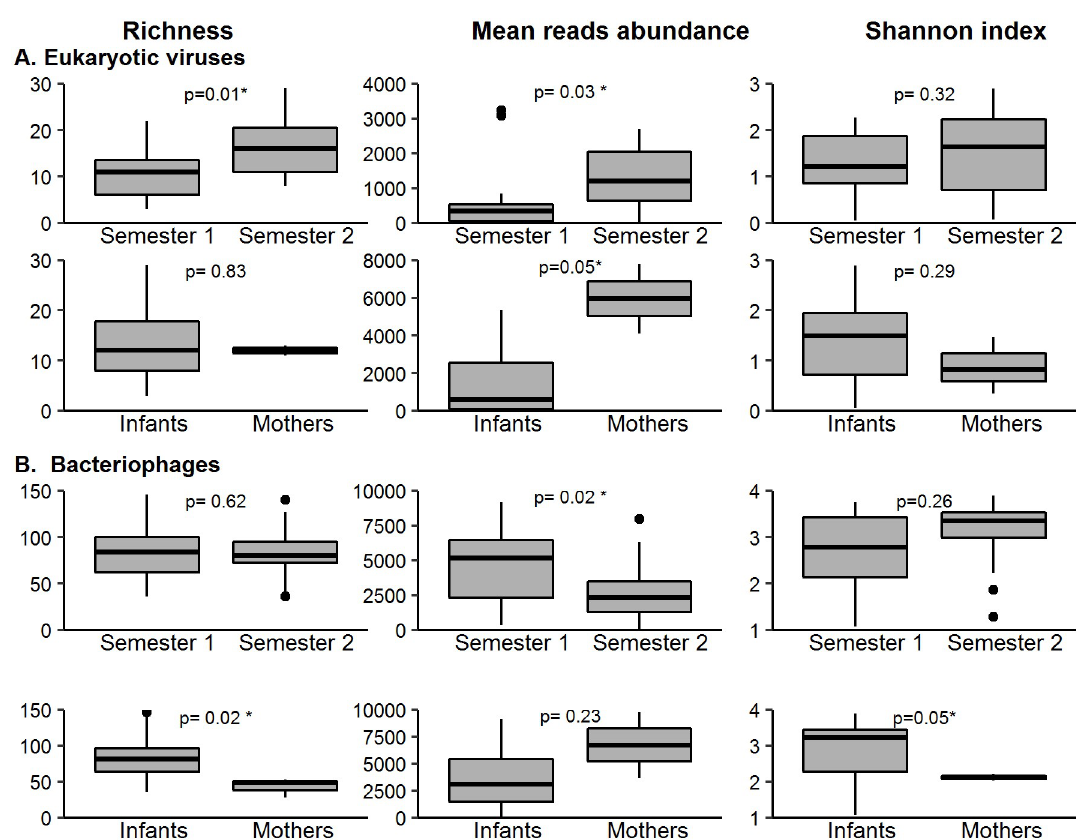
Fig 5. Bar plots representing viral diversity metrics as Chao richness index, mean abundance per species and Shannon diversity index. The metrics of the first vs. the second semester of infants, as well as the metrics of mothers as compared to those of infants, are compared. A) Eukaryotic viral diversity metrics. B) Bacteriophage diversity